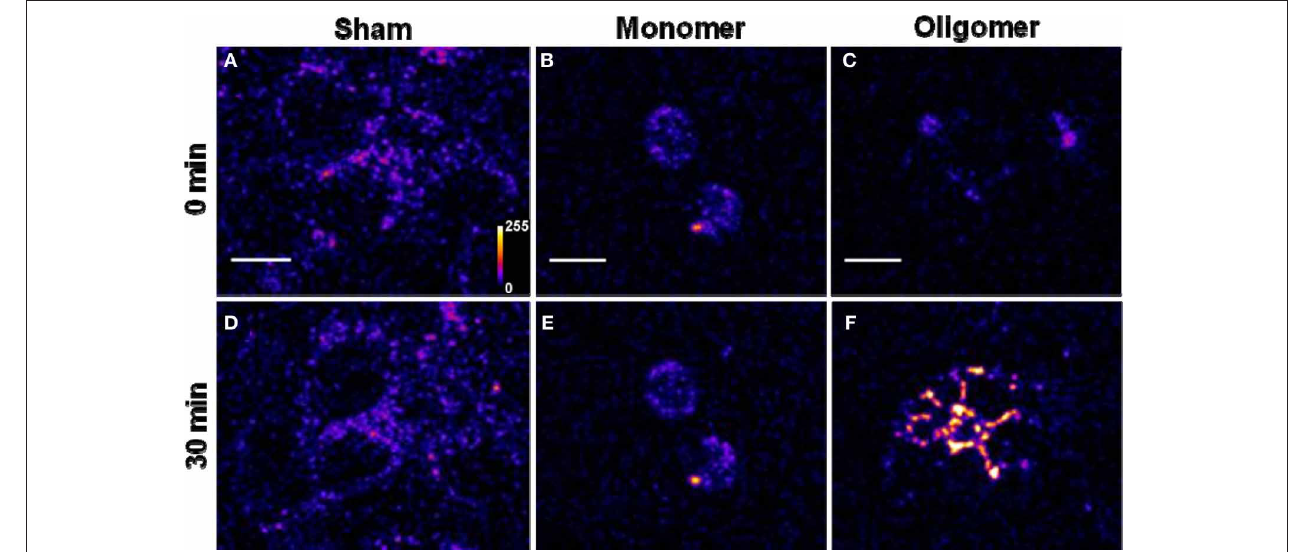
FIGURE 2 | Binding of A β 42 monomers and oligomers to HEK293T cell membranes. (A–C) Confocal sections of three sets of cells (excitation 543nm, emission 550–700nm). (D–F) Corresponding sets of cells after